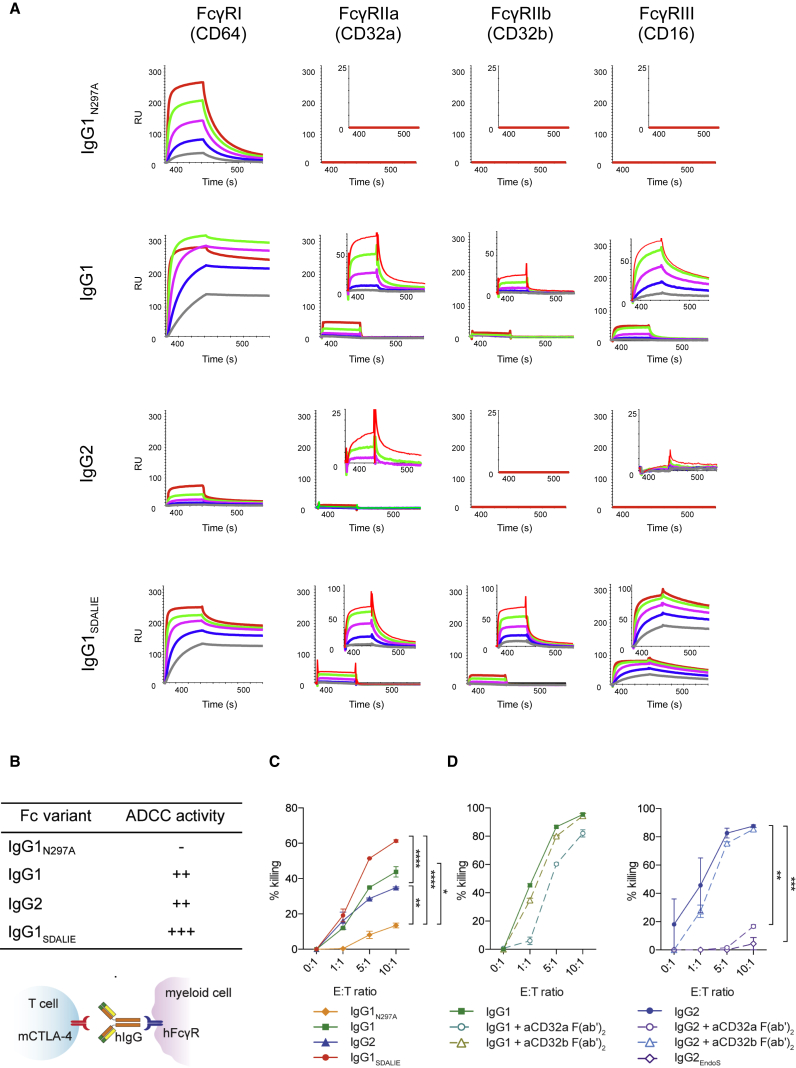
Anti-CTLA-4 Antibodies of IgG1 and IgG2 Isotype Mediate Depletion of CTLA-4-Expressing Target Cells In Vitro(A) SPR analysis of anti-murine CTLA-4 with human IgG variants. Large graphs demonstrate interaction of free monomeric FcγRs at increasing FcγR concentrations with immobilized IgG variants; inset graphs show interaction of immobilized IgG variants with aggregated low-affinity FcγRs at increasing concentrations. RU, response units.(B) Schematic representation of the mechanism of action of chimeric anti-mCTLA-4 antibodies and predicted ADCC activity for each human IgG variant.(C) In vitro ADCC assay with human monocyte-derived macrophages and mCTLA-4+ target cells in the presence of anti-mCTLA-4 mAbs with different human IgG variants.(D) ADCC assay in the presence of CD32a or CD32b-blocking F(ab’)2 antibody fragments and with a deglycosylated IgG2 mAb (IgG2EndoS).Results are representative of three independent experiments. Error bars show ±SEM of experimental triplicates. ∗p < 0.05; ∗∗p < 0.01; ∗∗∗p < 0.001; ∗∗∗∗p < 0.0001. See also Figure S3.